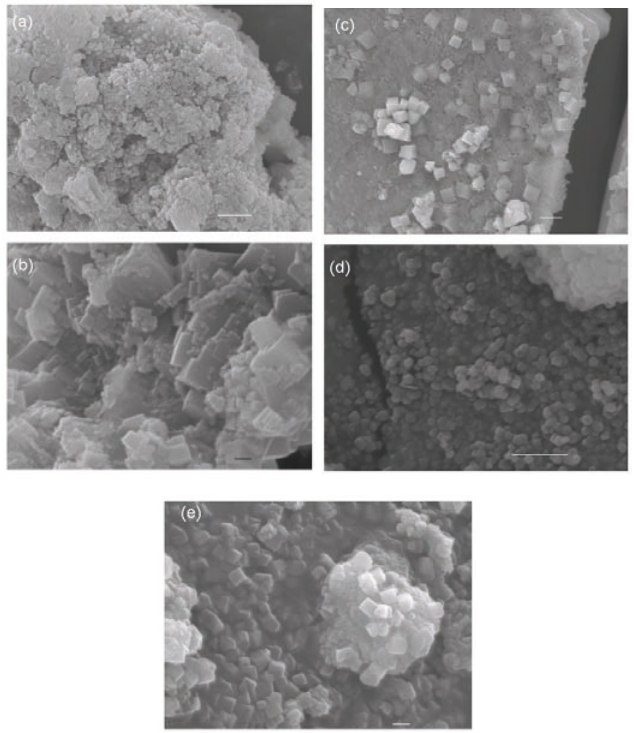
Figure 3. SEM images of MSn(OH) materials M = (a) Mn, (b) Cu, (c) Zn, (d) Mg, and (e) Ca. Markers in the images represent 1 μm for all except 6 (b) and (e) (100